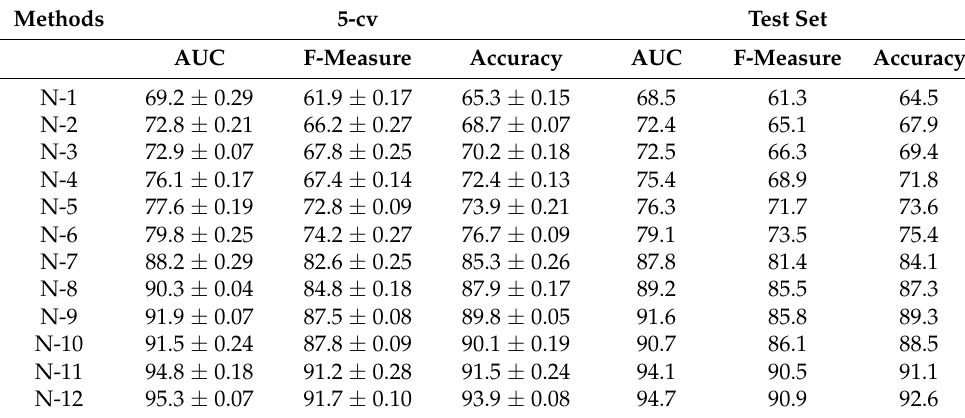
Table 1. Computational results of the proposed models.